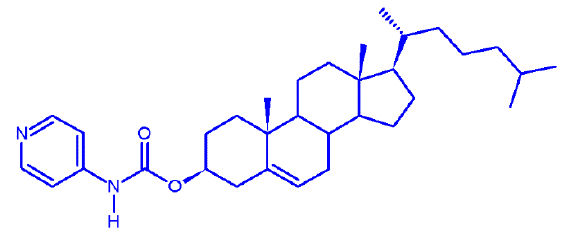
Figure 1. Molecular structure of 4-pyridyl cholesterol (PC).